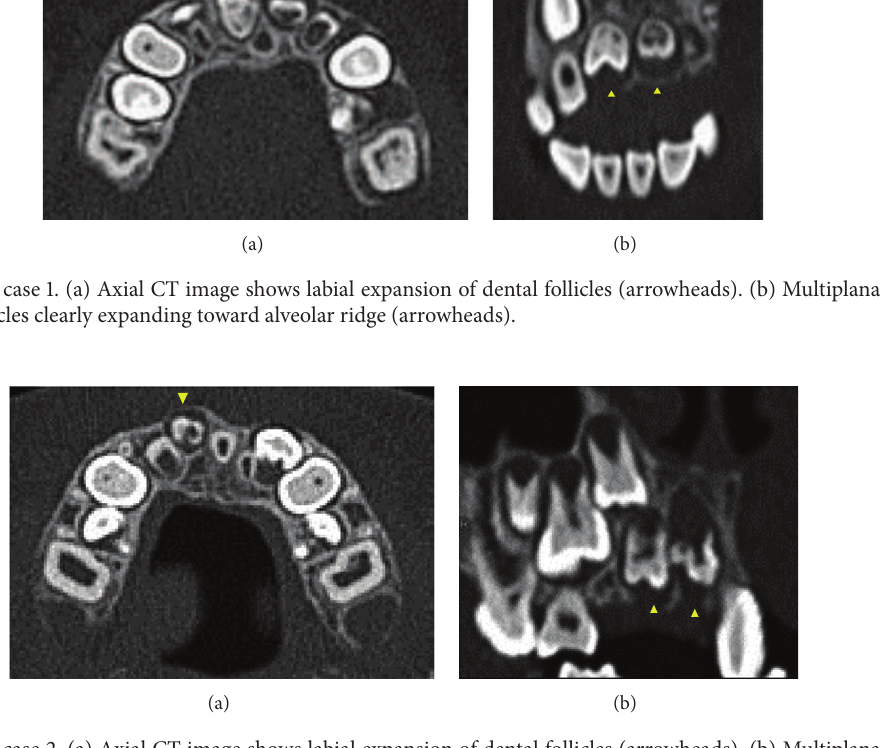
Figure 8: CT images of case 2. (a) Axial CT image shows labial expansion of dental follicles (arrowheads). (b) Multiplanar reconstruction image shows dental follicles clearly expanding toward alveolar ridge